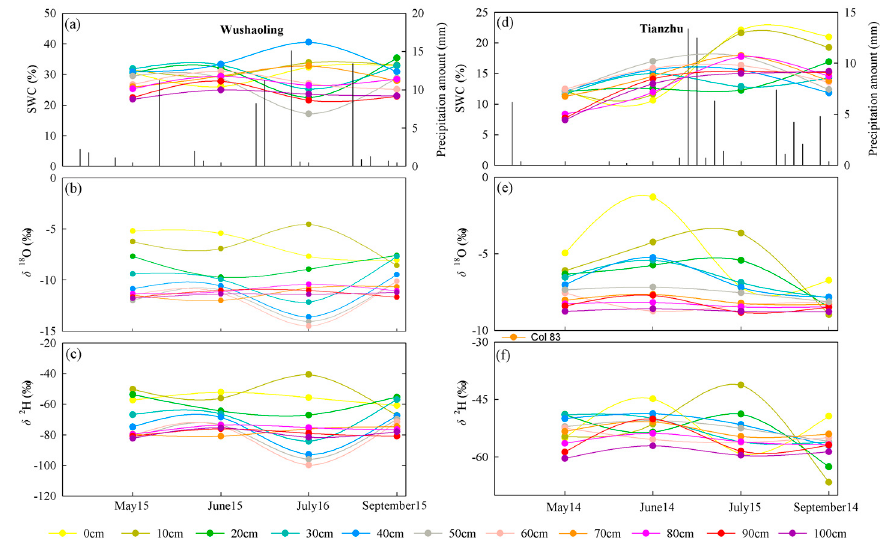
Figure 5. The response of soil water, δ 18 O, and δ 2 H to di ff erent amounts. ( a – c ) are the response of SWC, δ 18 O, and δ 2 H to precipitation pulsse at Wushaoling, and ( d – f ) are for the responses at